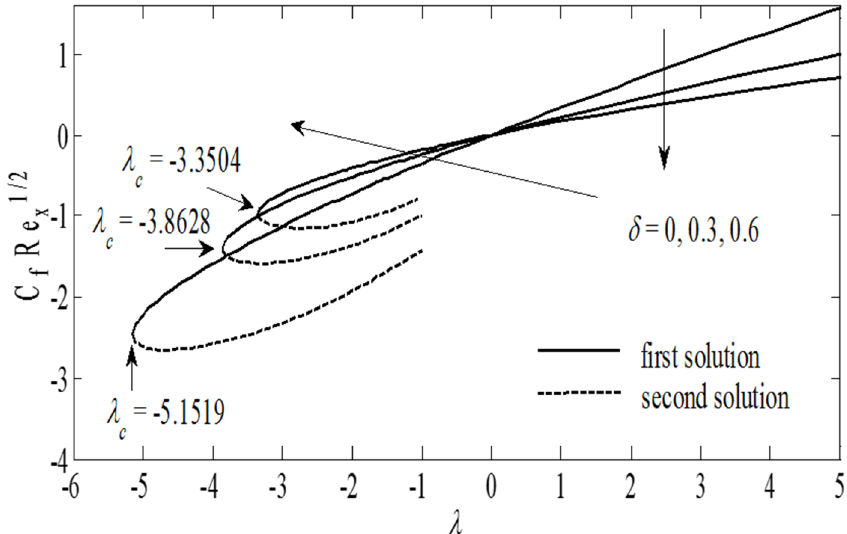
λ for different values of δ when ε = 1 and Pr =